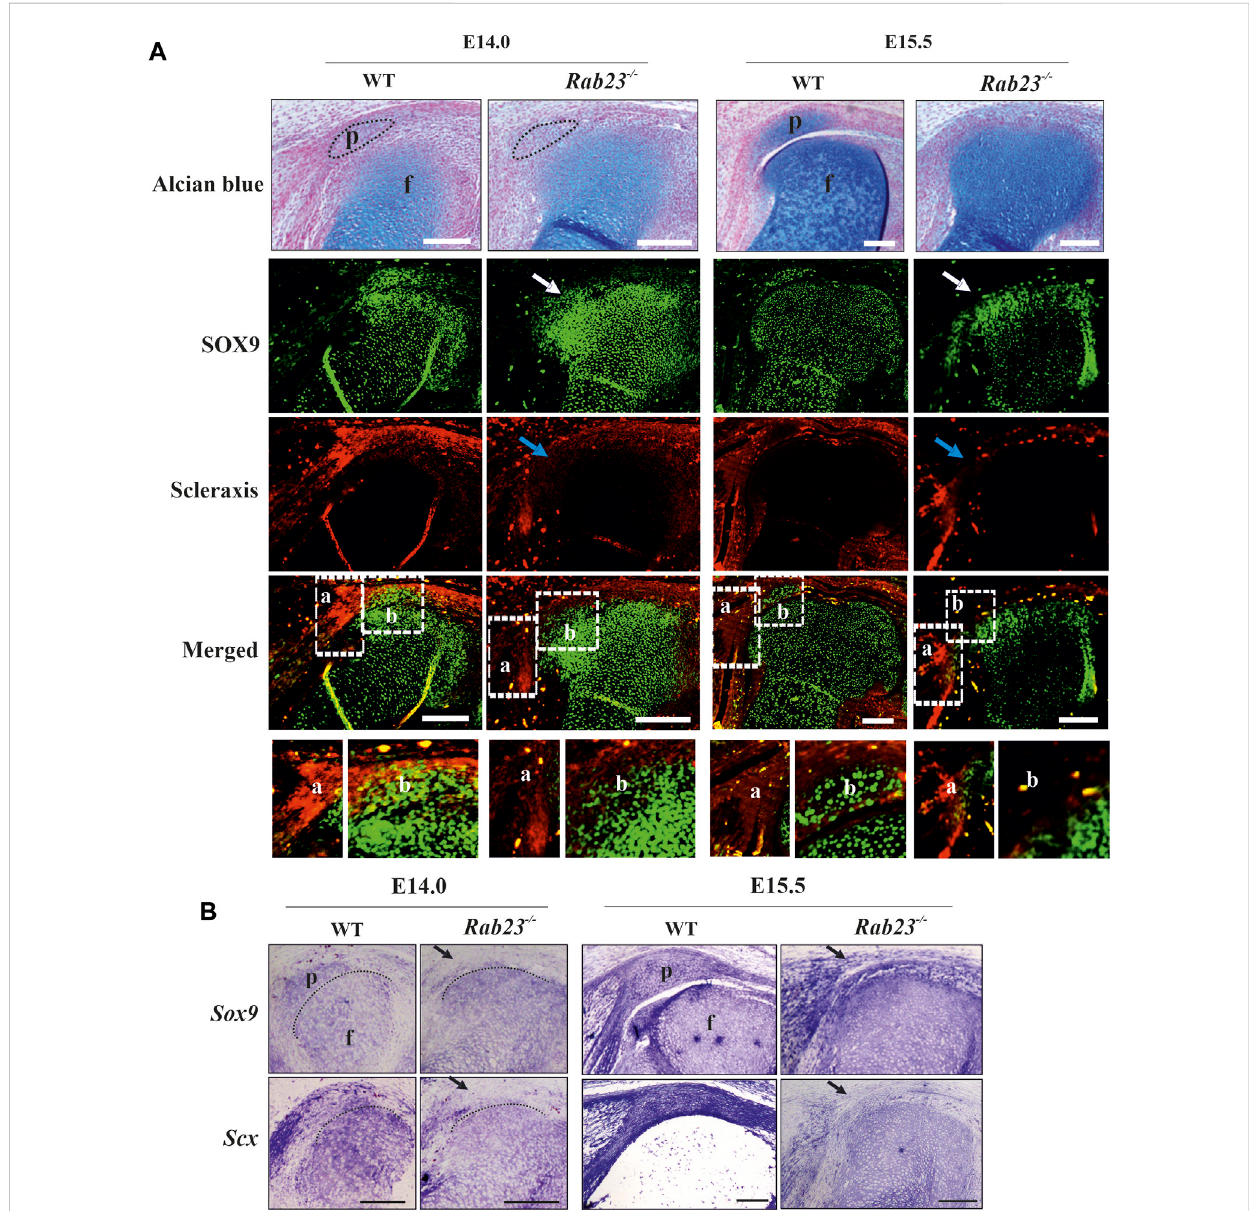
FIGURE 2 RAB23 de fi ciency failed to specify Scx and SOX9 double-positive patella progenitor cells. (A, B) Immunohistochemical (A) and in situ (B) expression analysis of Scleraxis (Scx) and SOX9 in the Wt and Rab23 − / − mice sagittal-sections of the hind limbs obtained from E14.0 and E15.5 embryos. Wt samples show the expression of Scx and SOX9 double-positive patella progenitor cells, while Rab23 − / − samples fail to express Scx and SOX9 double-positive progenitor cells (A) . In Wt samples, Scx shows robust expression in the future patella site (E14.0) and shows expression in the patella tendon, quadricepstendon,rectus femoris,andvastus medialis tendon (A,B) .Scxexpressionin Rab23 − / − samplesismissing inthefuturepatellasiteatE14.0(blue arrow) and is barely detectable in the malformed patella tendon-like structure and quadriceps tendon (A, B) . At E15.5 in Rab23 − / − samples, Scx remained undetectableatthepatella site(blue arrowand black arrow) and shows rudimentaryexpressioninthepatella tendon andin thequadriceps tendon (A, B) . Analysis of SOX9 expression shows that in Wt samples, SOX9 was expressed in the future patella site at E14.0 and in the patella at E15.5 (A, B) . In Rab23 − / − samples, SOX9 was initially barely expressed in the future patella site at E14.0 (white arrow and black arrow) but was abolished at E15.5 samples (white arrow) (A) . While SOX9 showed uniform expression throughout the articular cartilage in the Wt femur toward the patella and tibia, Rab23 − / − samples showed more SOX9 expressions in the femur head toward the imaginary patellofemoral site (A, B) . To highlight the cartilage cells of the patella, sagittal sections from E14.0 and E15.5 hind limbs were stained with Alcian blue and fast red (A, upper panel). Black dotted oval shape indicates the future patella site (A) .Blackdottedmarkingindicatestheendofthefemurtowardthepatella (B) ( n =3samplesforeachageandgenotype).p:patellaandf:femur.Scale bar: 200 μ m.